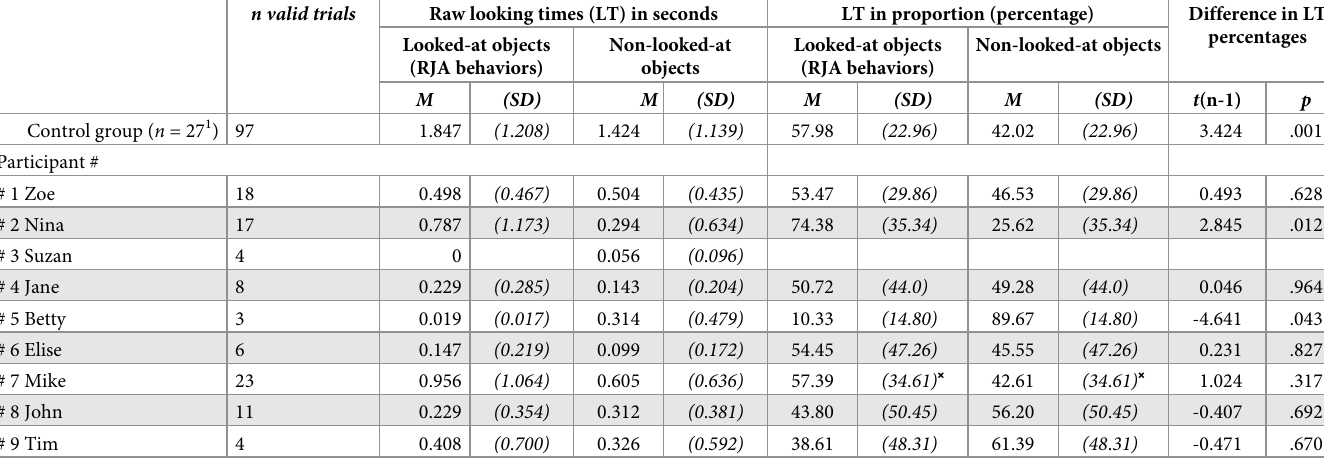
Table 9. Mean (and SD ) looking times (raw and percentage) at each of the two stimuli of the RJA-Task (i.e., looked-at vs. non-looked-at objects), consisting of four 15-second trials, of the control group and the nine PIMD participants. n valid